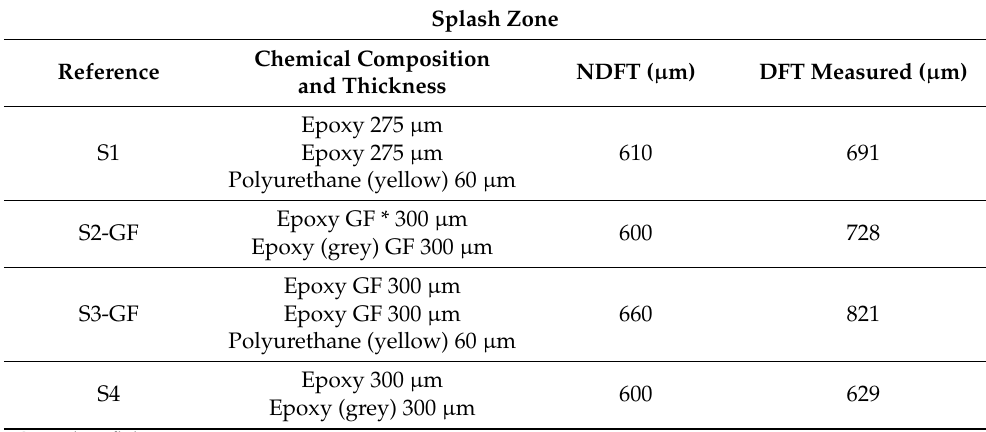
Table 5. Selected coating systems for the splash